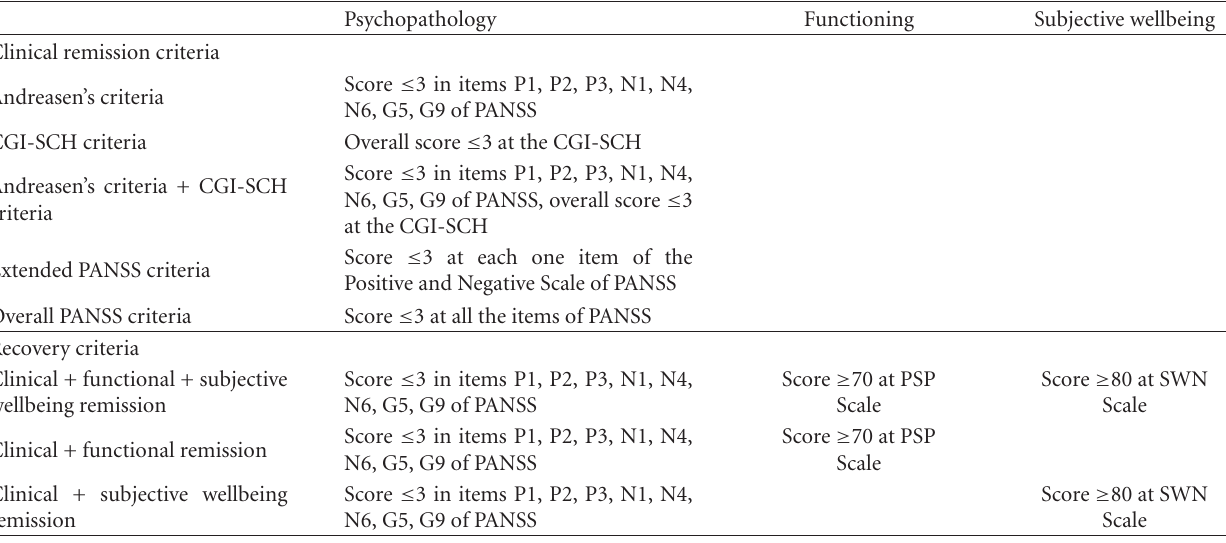
Table 1: Clinical remission and recovery criteria.